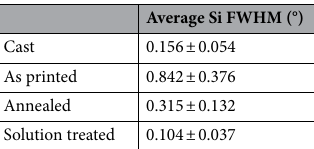
Table 1. Average Si FWHM values calculated with the High Score Plus software for the different samples.